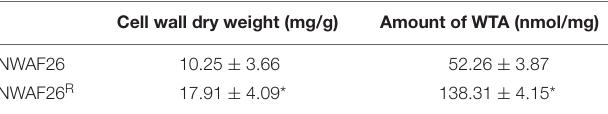
TABLE 4 | Wall teichoic acid (WTA) in the NWAF26 and NWAF26 R